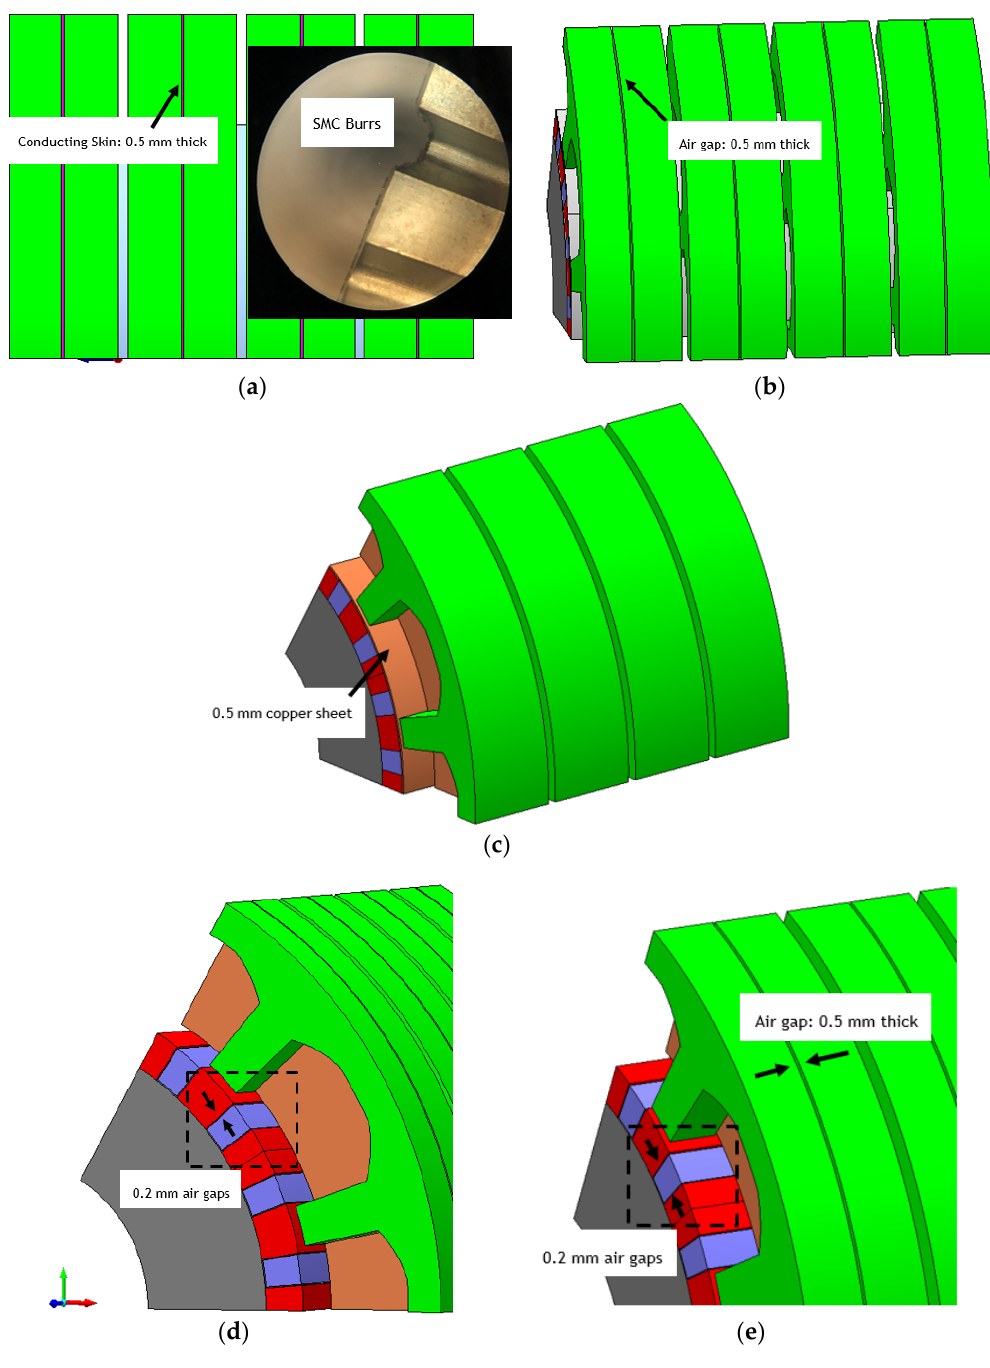
Figure 19. Manufacturing and material related uncertainties for the proposed TFM alternator, ( a ) conducting skin between the segments, ( b ) axial contact gaps, ( c ) rotor grinding causing conducting skin, ( d ) air gaps between the rotor poles, ( e ) combination of rotor clearance air gaps and stator axial contact voids.